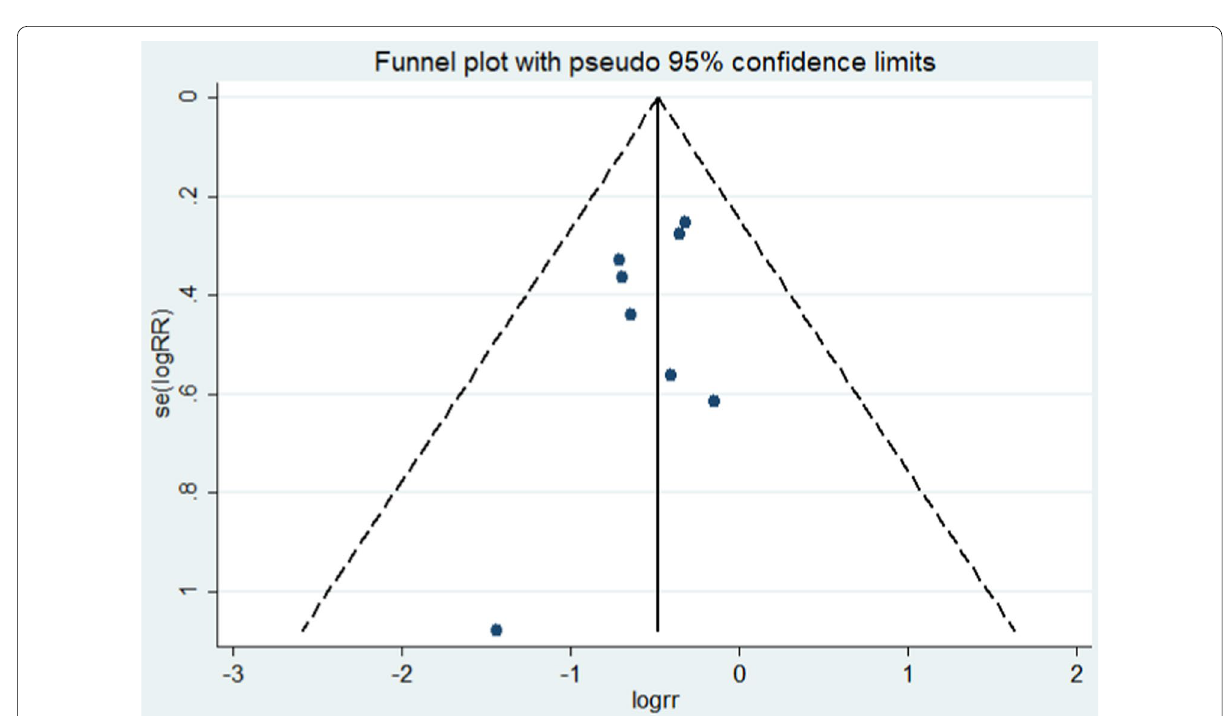
Fig. 3 Funnel plot of publication bias. Two studies were omitted just in case of double counting [5,